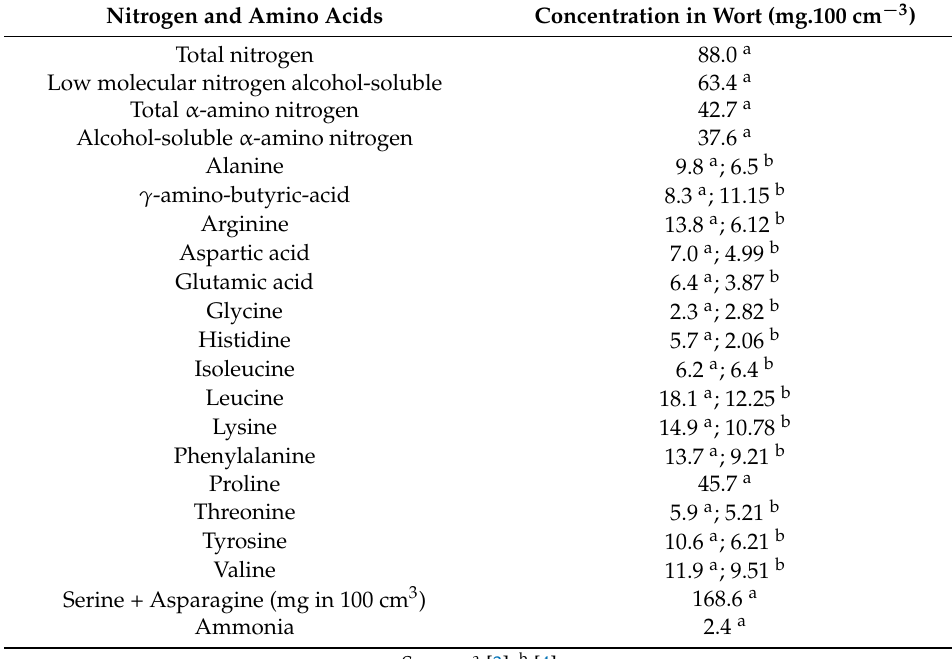
Table 1. Amino acids in wort composition and their respective concentration (mg.100 cm − 3